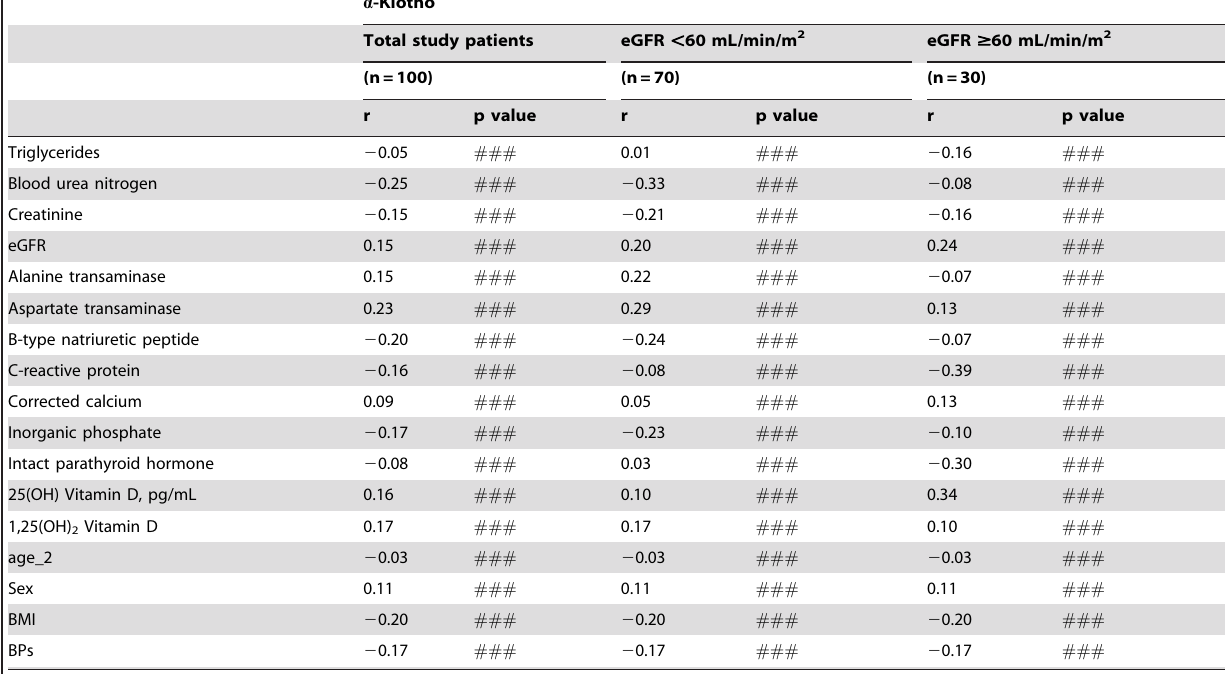
a -Klotho Total study